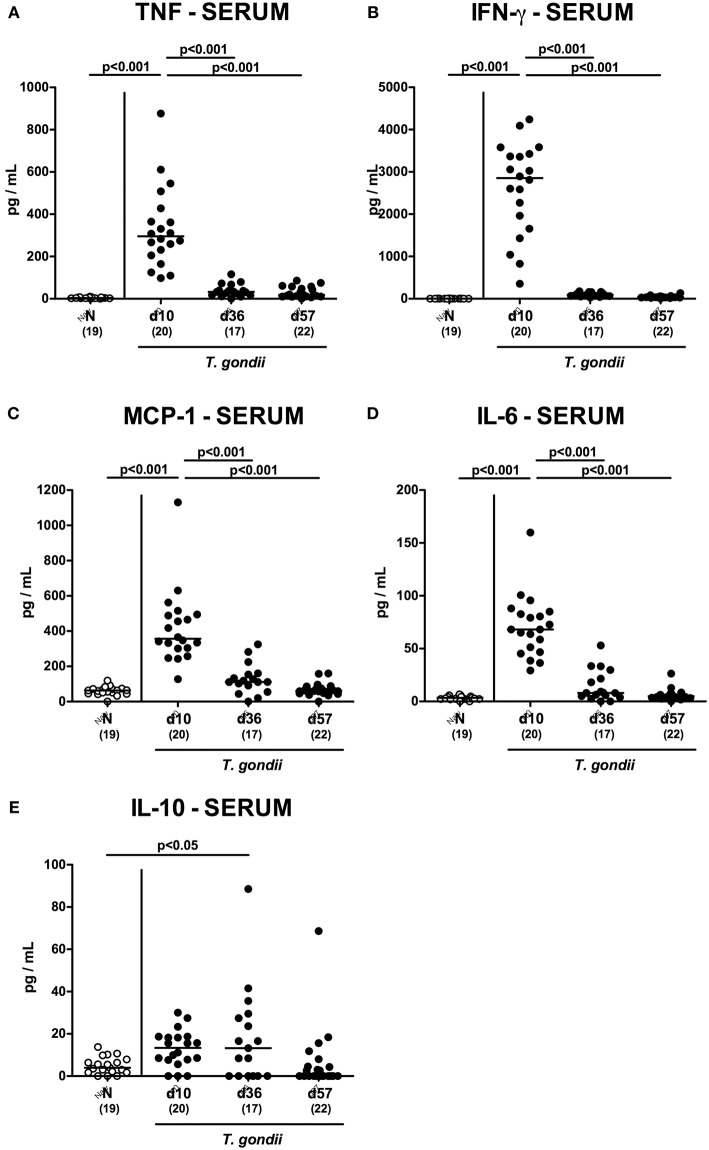
Systemic inflammatory mediator secretion over time following peroral low-dose T. gondii infection. Mice were perorally infected with one cyst of T. gondii on day 0 and surveyed at days (d) 10, 36, and 57 post-infection (p.i.; closed circles). Naive (N) mice served as uninfected controls (open circles). (A) TNF, (B) IFN-γ, (C) MCP-1, (D) IL-6 and (E) IL-10 concentrations were measured in serum samples taken at respective time points. Medians (black bars), levels of significance (p-values) as determined by one-way ANOVA test followed by Tukey post-correction for multiple comparisons and numbers of analyzed mice (in parentheses) are indicated. Data were pooled from four independent experiments.